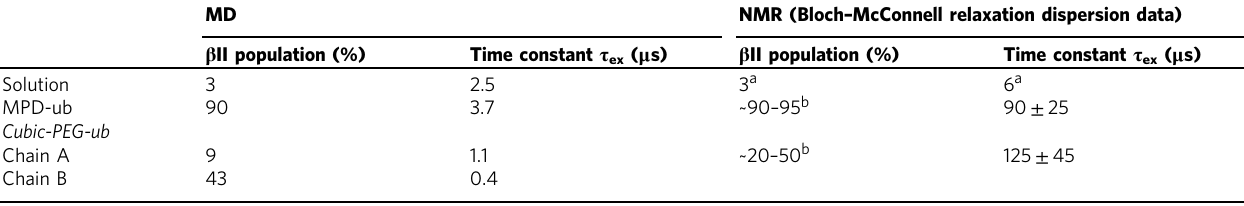
Table 1 Populations and time scales of conformational exchange dynamics in the region encompassing residues L50 – L56 and the adjacent N-terminal part of the α